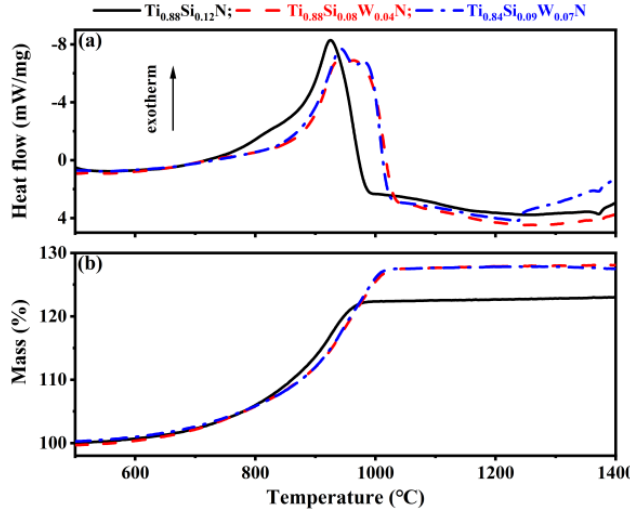
Figure 7. Synchronous ( a ) DSC and ( b ) TGA curves of Ti 0.88 Si 0.12 N, Ti 0.88 Si 0.08 W 0.04 N, and Ti 0.84 Si 0.09 W 0.07 N powdered coatings in ambient air. To better explore the oxidation behavior of Ti 0.88 Si 0.12 N, Ti 0.88 Si 0.08 W 0.04 N, and Ti 0.84 Si 0.09 W 0.07 N coatings, XRD determinations were performed. As shown in Figure 8a, several inconspicuous anatase (a-) and rutile (r-) TiO 2 peaks are detected in Ti 0.88 Si 0.12